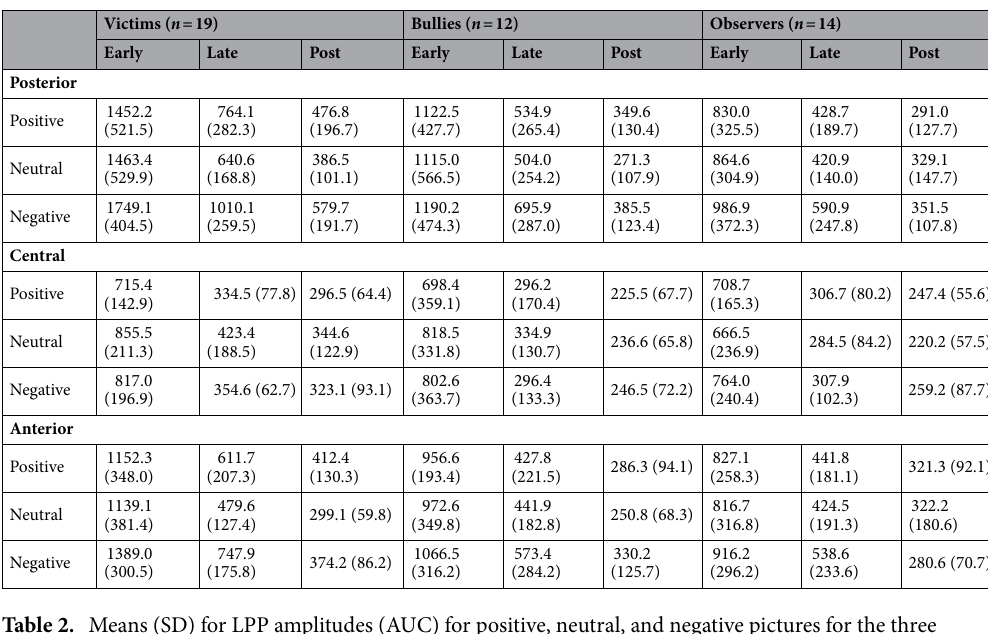
Table 2. Means (SD) for LPP amplitudes (AUC) for positive, neutral, and negative pictures for the three regions (posterior, central, and anterior). LPP time windows are divided into early (300–700 ms), late (700– 1000 ms), and post stimuli (1000–1300 ms). SD Standard deviation, AUC Area under the curve, LPP Late positive potential.